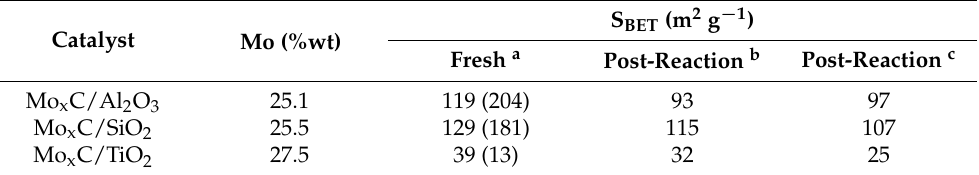
Table 1. Mo content, determined by chemical analysis and surface area (S BET ) of fresh and post- reaction